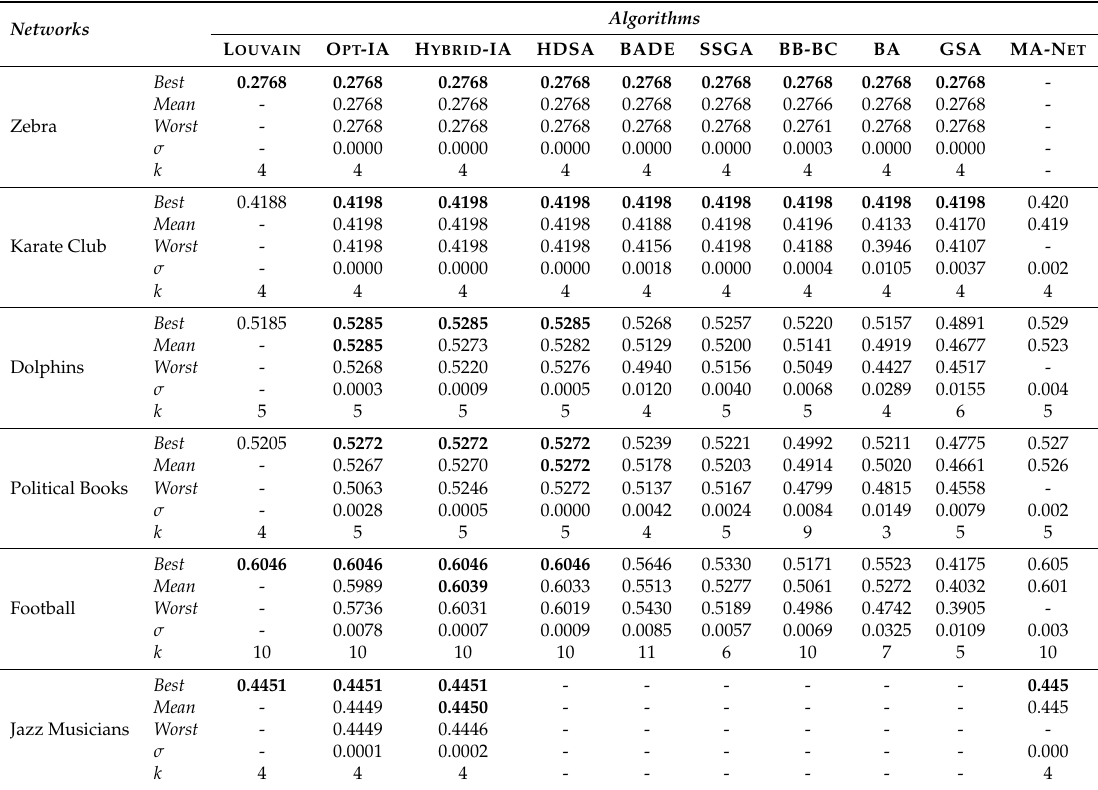
Table 2. Comparison of O PT -IA and H YBRID -IA on social networks with reference algorithms. For HDSA, BADE, SSGA, BB-BC, BA, and GSA the results are calculated over 30 independent runs, while for MA-N ET over 50 independent